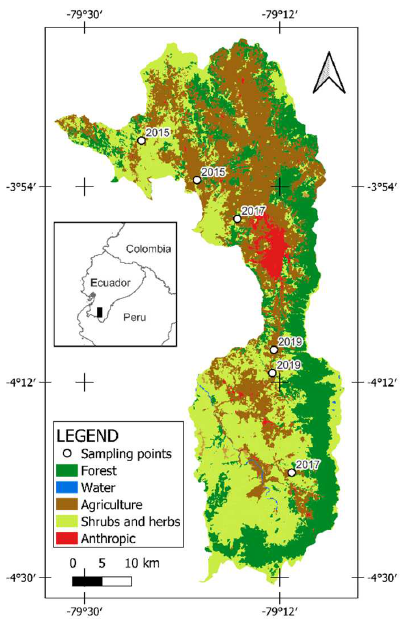
Figure 1. Location of the study area, Loja canton, southern Ecuador.